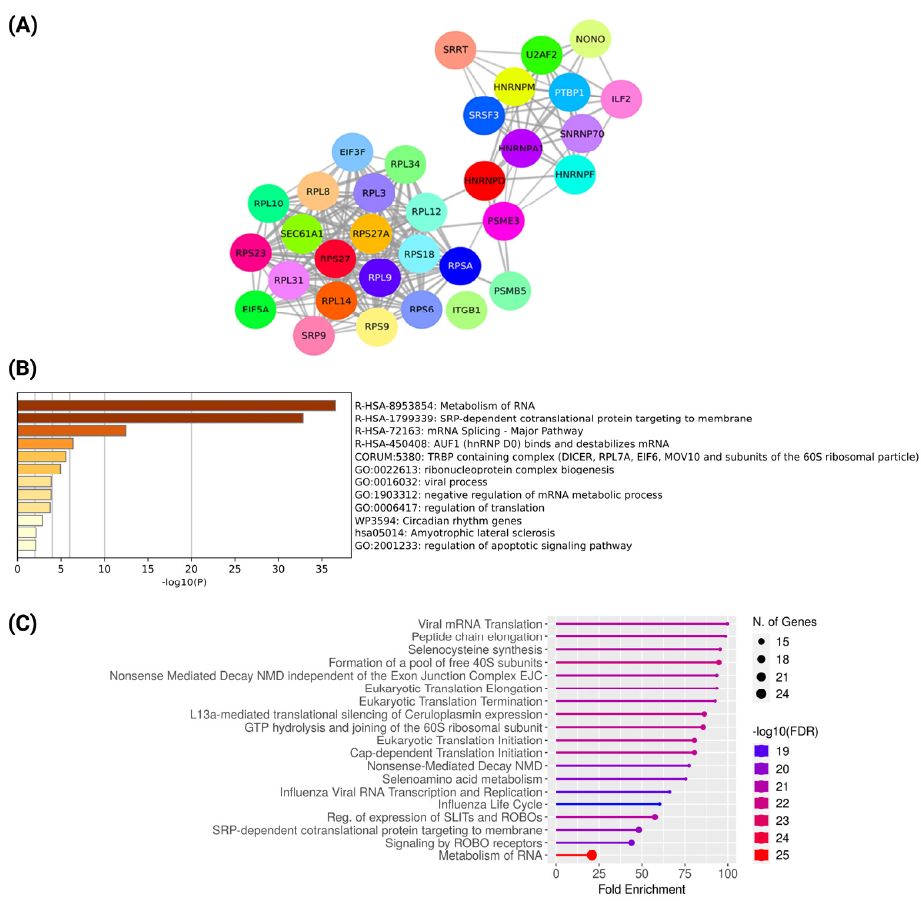
Figure 3. ( A ) Protein–protein interaction network of hub genes associated with NAC resistance in breast cancer. The plot was prepared using STRING. ( B ) Significantly enriched biological processes and pathways associated with the hub genes. Enrichment analysis performed using Metascape. ( C ) Significantly enriched reactome pathways associated with the hub genes. Enrichment analysis was performed using ShinyGO.